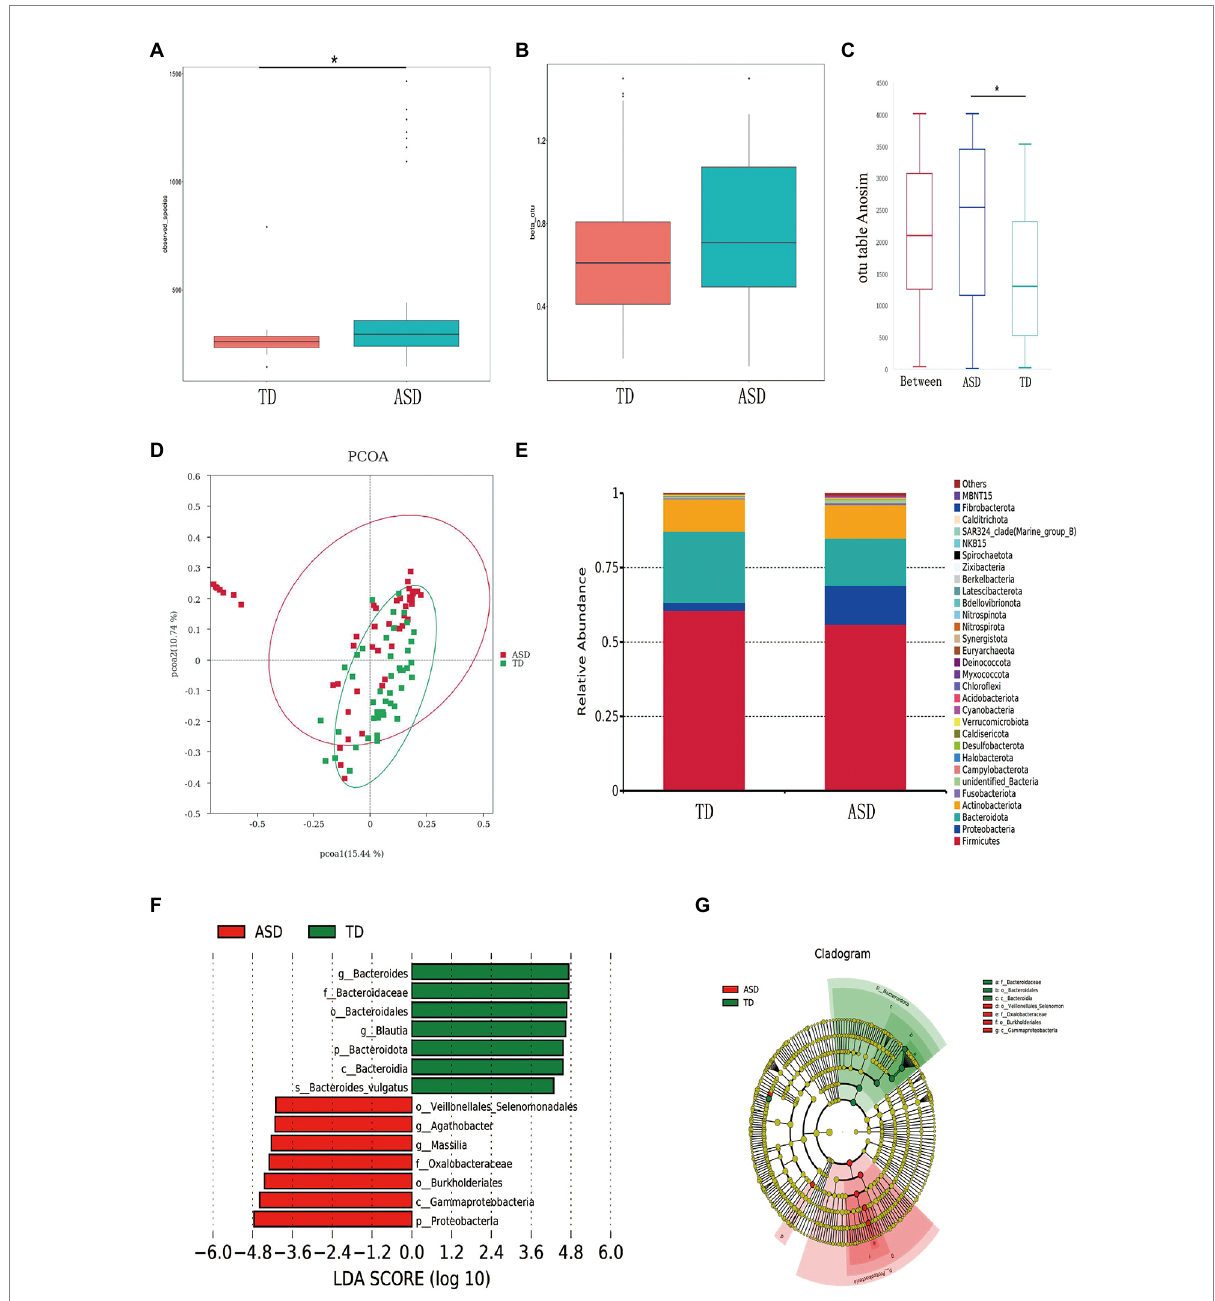
FIGURE 2 The shape of the microbiota in typically developing (TD) children and children with ASD. (A) Comparison of bacterial richness (observed_species) and (B) diversity (beta_otu). (C) ANOSIM was used to compare within-and between-group similarities (R = 0.1337, p = 0.001). (D) Principal coordinate analysis (PCoA) of the microbiota in the TD and ASD groups by using unweighted UniFrac distance metrics. (E) The relative abundance of different taxa at the phylum level in ASD and TD. (F) LDA scores for bacterial taxa that diverge in abundance between TD and ASD (LDA > 4). (G) The cladogram illustrates the enriched taxa of gut microbiota in ASD and